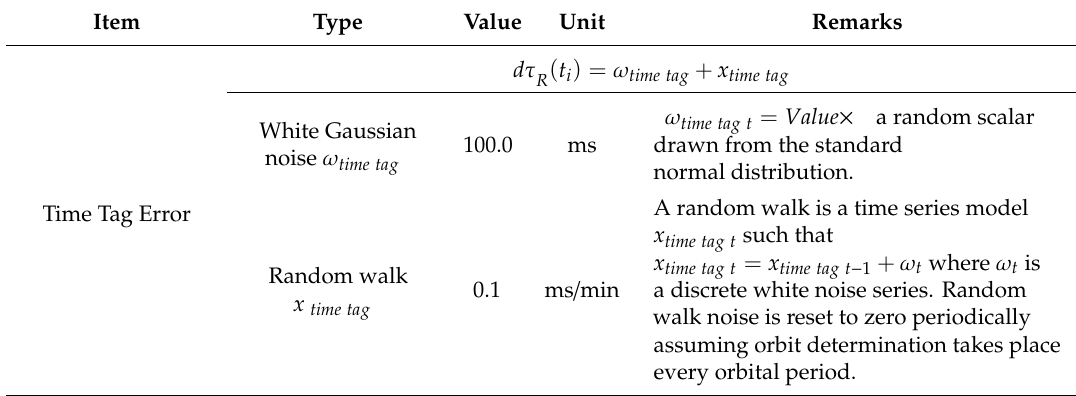
Table 5. Overview of time tag error used in the simulation.